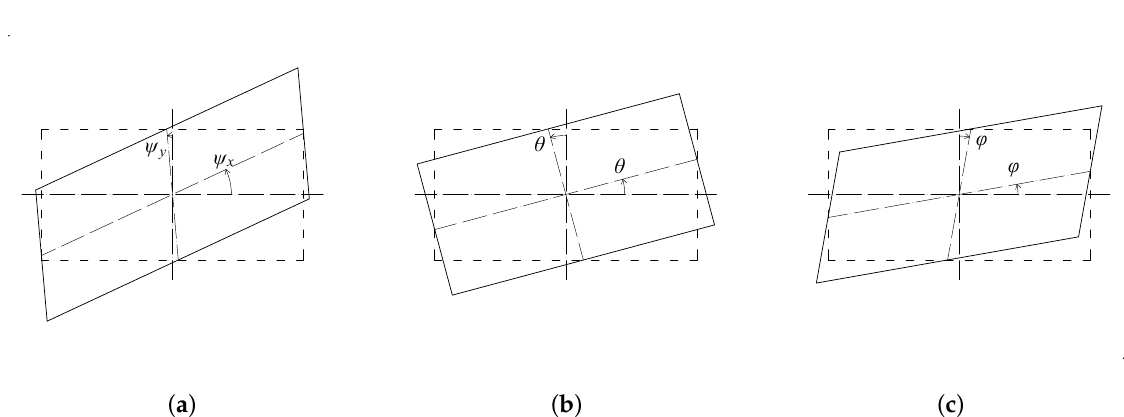
Figure 2. Decomposition of the cross-sectional transformation: ( a ) current configuration, ( b ) skew-symmetric part (twist), and ( c ) symmetric part (distortion). Compatibility at corners to be accounted for